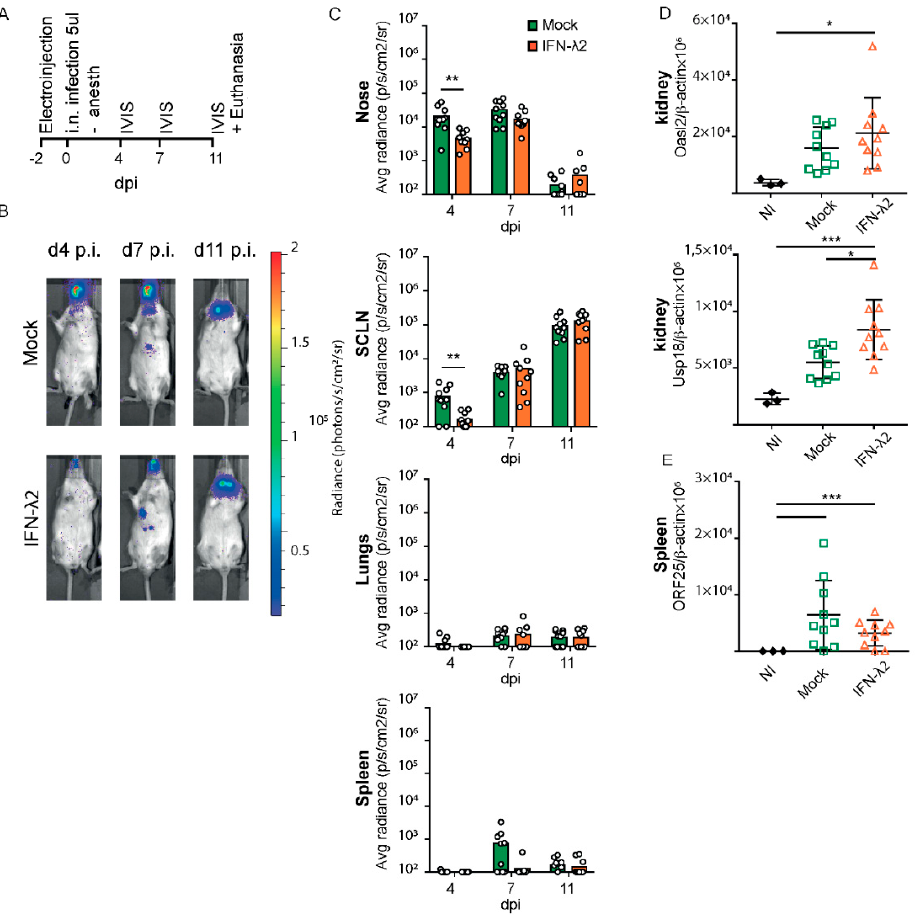
Figure 3. Bioluminescence analysis of MuHV-4 after intranasal inoculation without anesthesia in mock or IFN- λ -treated mice. ( A ) Eight week-old female BALB/c mice were electroinjected with an empty plasmid (mock, n = 10) or a plasmid expressing IFN- λ 2 (IFN- λ 2, n = 10). Two days later, alert mice were infected by intranasal (i.n.) injection with 5 × 10 4 PFU Luc+ MuHV-4 in 5 μ L and imaged at the times indicated. ( B ) Representative images are shown for mock or IFN- λ 2 electroinjected groups at days four, seven, and 11 p.i. ( C ) Signal intensities were compared for the nose, superficial cervical lymph nodes (SCLNs), lungs, and spleen between groups. ( D ) Amounts of Oasl2 and